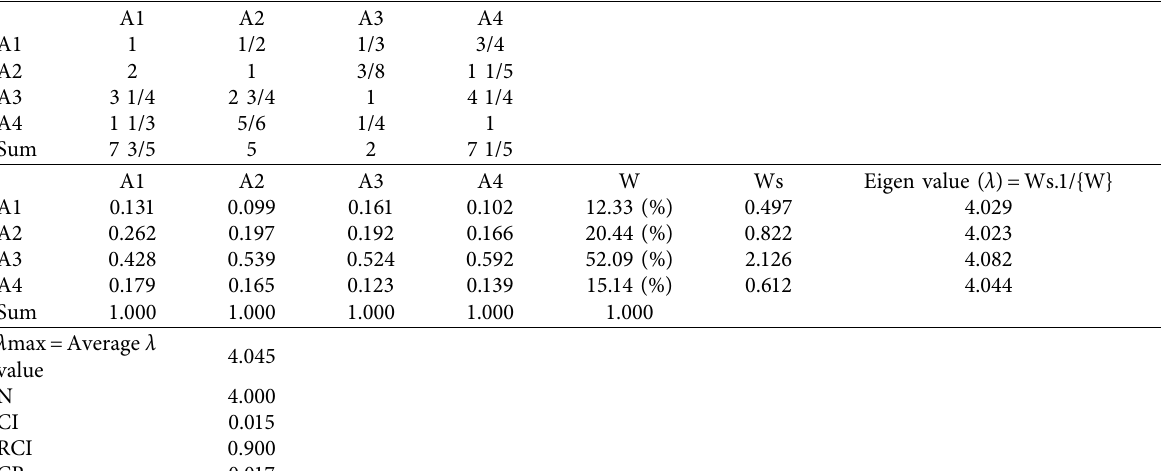
Table 6: Comparison of alternatives on the bases of life cycle cost.